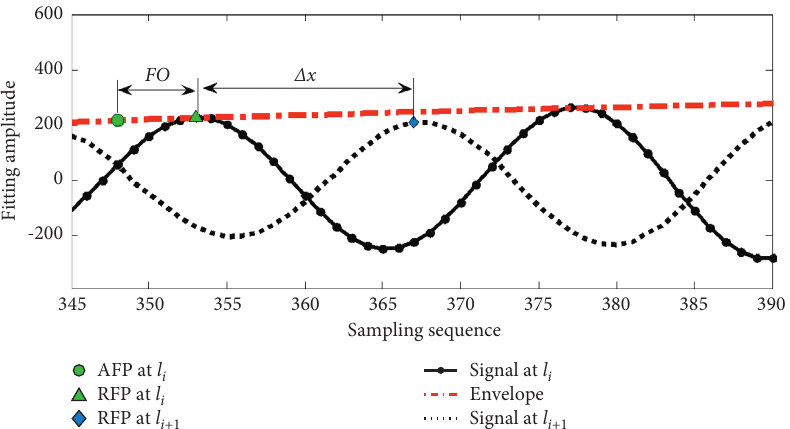
Figure 3: The sketch of FO and ∆ x .